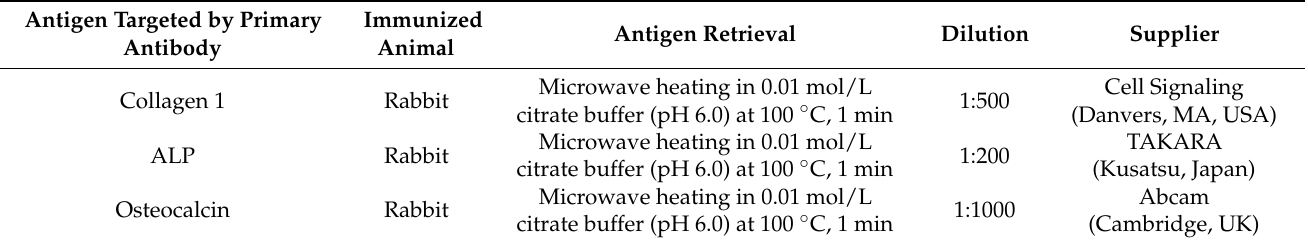
Table 2. Antibodies used for immunohistochemistry.